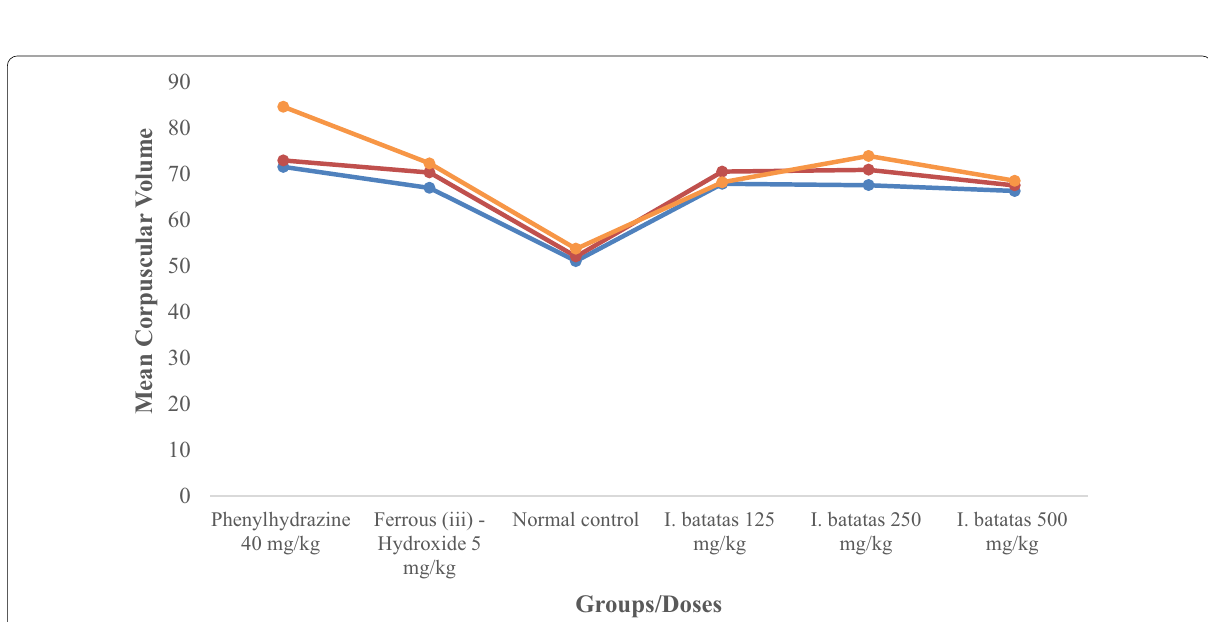
Fig. 5 Effect of Ipomoea batatas L . n-hexane leaves extract on mean corpuscular volume in phenylhydrazine-induced anaemic rats. Blue—day 1, red—day 7, orange—day